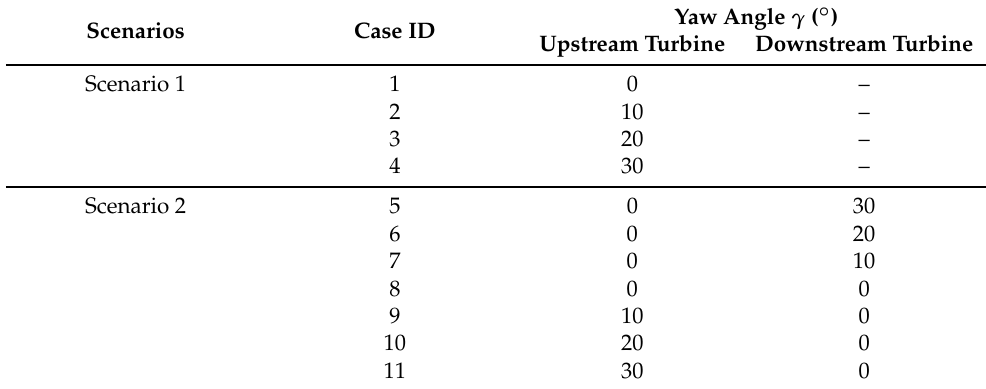
Table 1. The yaw angle values considered for each experiment